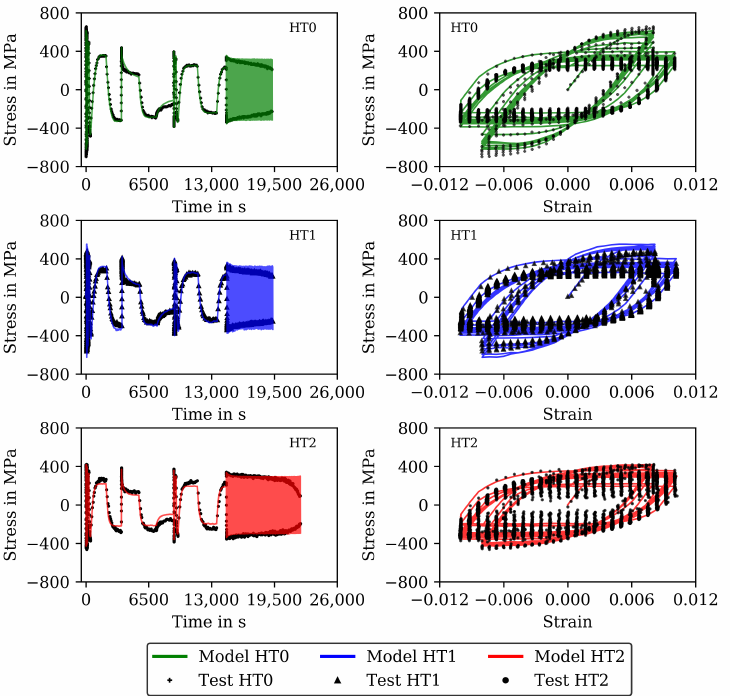
Figure 5. Measured stress and stress calculated with the model of step 2 for all cycles to failure of the CLCF tests at 650 ◦ C for the HT0, HT1 and HT2 material. Stress–time diagrams ( left ) and stress–strain hysteresis loops ( right ).